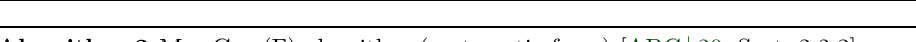
Algorithm 2 MatGen (Γ) algorithm (systematic form) [ABC + 20, Sect. 2.2.2].